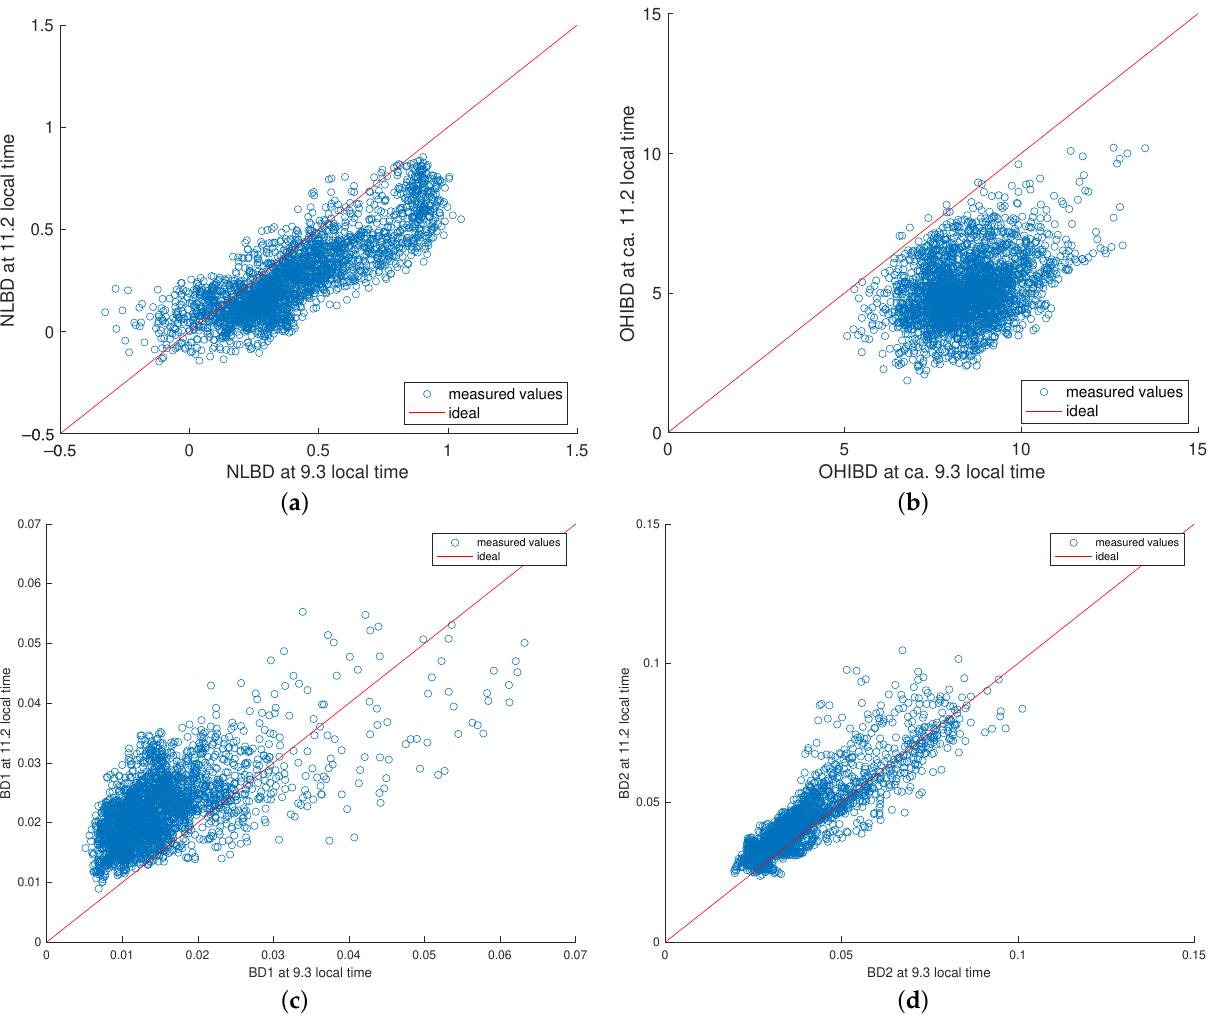
Figure 2. Studied parameters for the two images at morning and midday of the region near Mare Moscoviense examined in this study (see Section 3.2.2). ( a ) NLBD, ( b ) OHIBD, ( c ) BD1, ( d ) BD2. Ti, with an abundance highly correlated with the abundance of opaque minerals [23] and whose most important representative is ilmenite [19], is distinguished in the NIR wavelength range by a low albedo and continuum slope towards 2.5 µ m [52] and a high LBD (low NLBD) value due to partial suppression of the 2 µ m pyroxene band [27]. In the UV wavelength range, the TiO 2 abundance is linearly correlated with the 321 nm and 415 nm reflectance ratio. This parameter was used by Sato et al. [24] to derive a TiO 2 abundance map from the global WAC mosaic. These abundance maps were used in this work to find relations to the hydration of the regolith. Furthermore, we employed